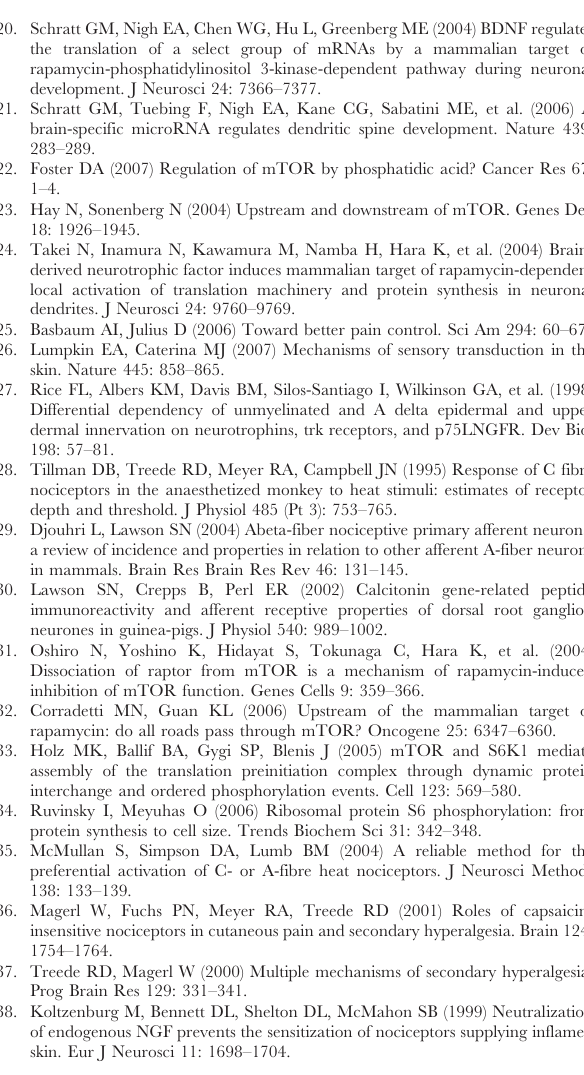
Figure S4 Anisomycin blocks capsaicin-induced secondary mechanical hyperalgesia. Secondary mechanical hyperalgesia in lateral plantar hindpaw was generated by injecting capsaicin into the central plantar surface of the hindpaw. Effect of lateral intraplantar injection of anisomycin (50 m l, 4.7 mM; 4 h before capsaicin) or vehicle on mechanical withdrawal threshold measured after injection of capsaicin using Von Frey hairs (A) and on withdrawal response duration to pinprick stimulation after capsaicin (B). (N =7–8 for Von Frey and N= 12 for pinprick). Found at: doi:10.1371/journal.pone.0001961.s007 (1.43 MB TIF) Figure S5 Ascomycin does not change the secondary mechan- ical hyperalgesia that follows capsaicin injection. Secondary mechanical hyperalgesia in lateral plantar hindpaw was generated by injecting capsaicin into the central plantar surface of the hindpaw. Effect of lateral intraplantar injection of ascomycin or